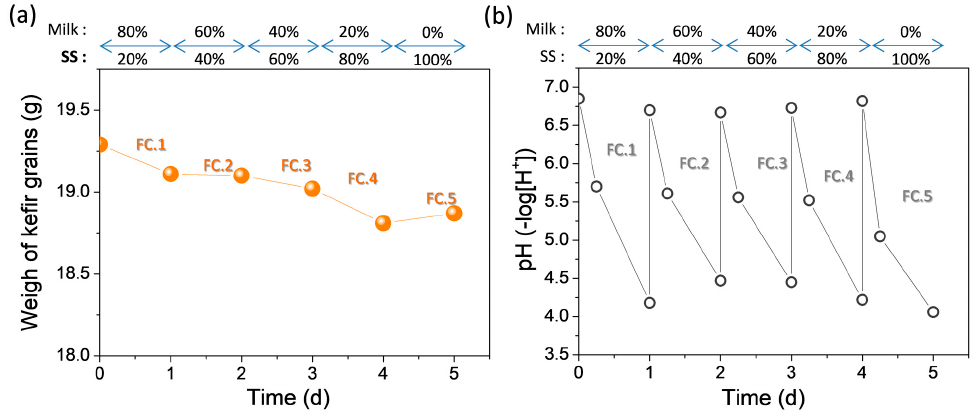
Figure 4. Weight change of kefir grains (a) and pH variation (b), during the gradual substitution of fermentation medium (from milk to sucrose solution) at 24 h fermentation cycles (FC).